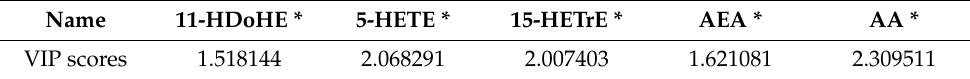
Table 3. VIP scores for five metabolites. A cutoff value of 1.5 is established for VIP selection.